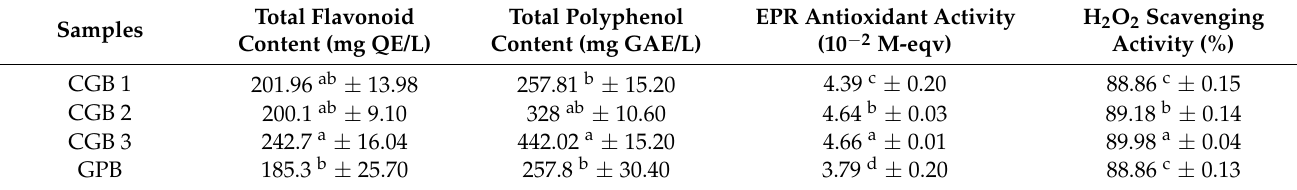
Table 2. Phytochemical and antioxidant activities of beers.